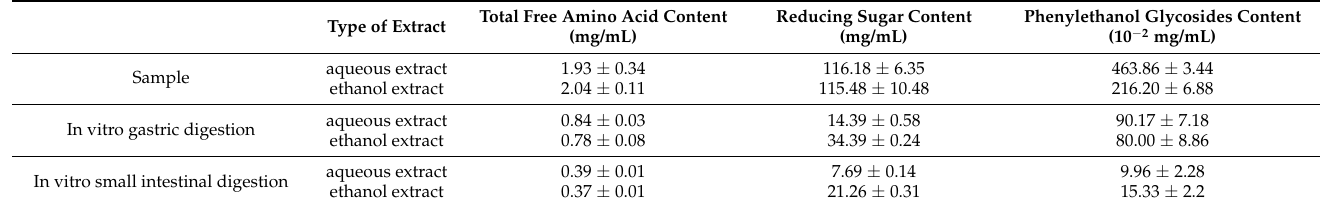
Table 1. Main chemical constituents of extracts and their digested products.